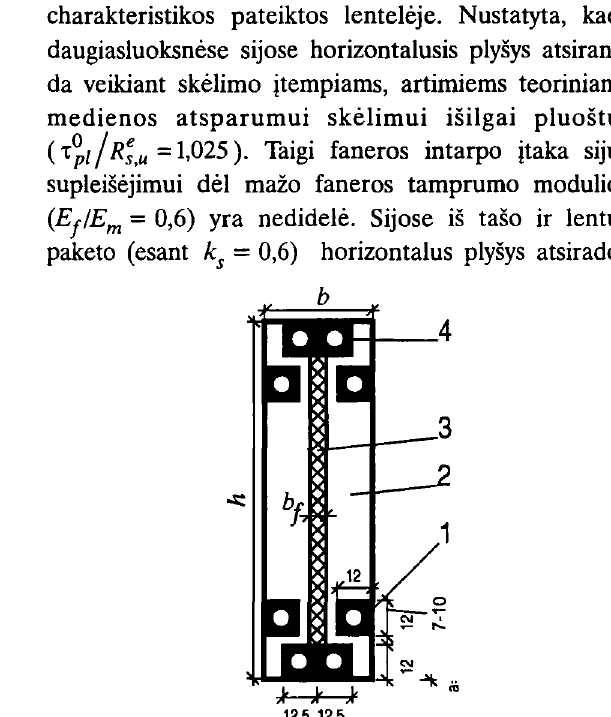
Fig 3. Cross-section of tested multilayered beams: 1 - 4010AIII reinforcement steel bars glued along whole beams length, 2 - pin boards, 3 - plywood brass, 4 - 4010AIII reinforcement steel bars of 80 em long glued in the middle of the beam